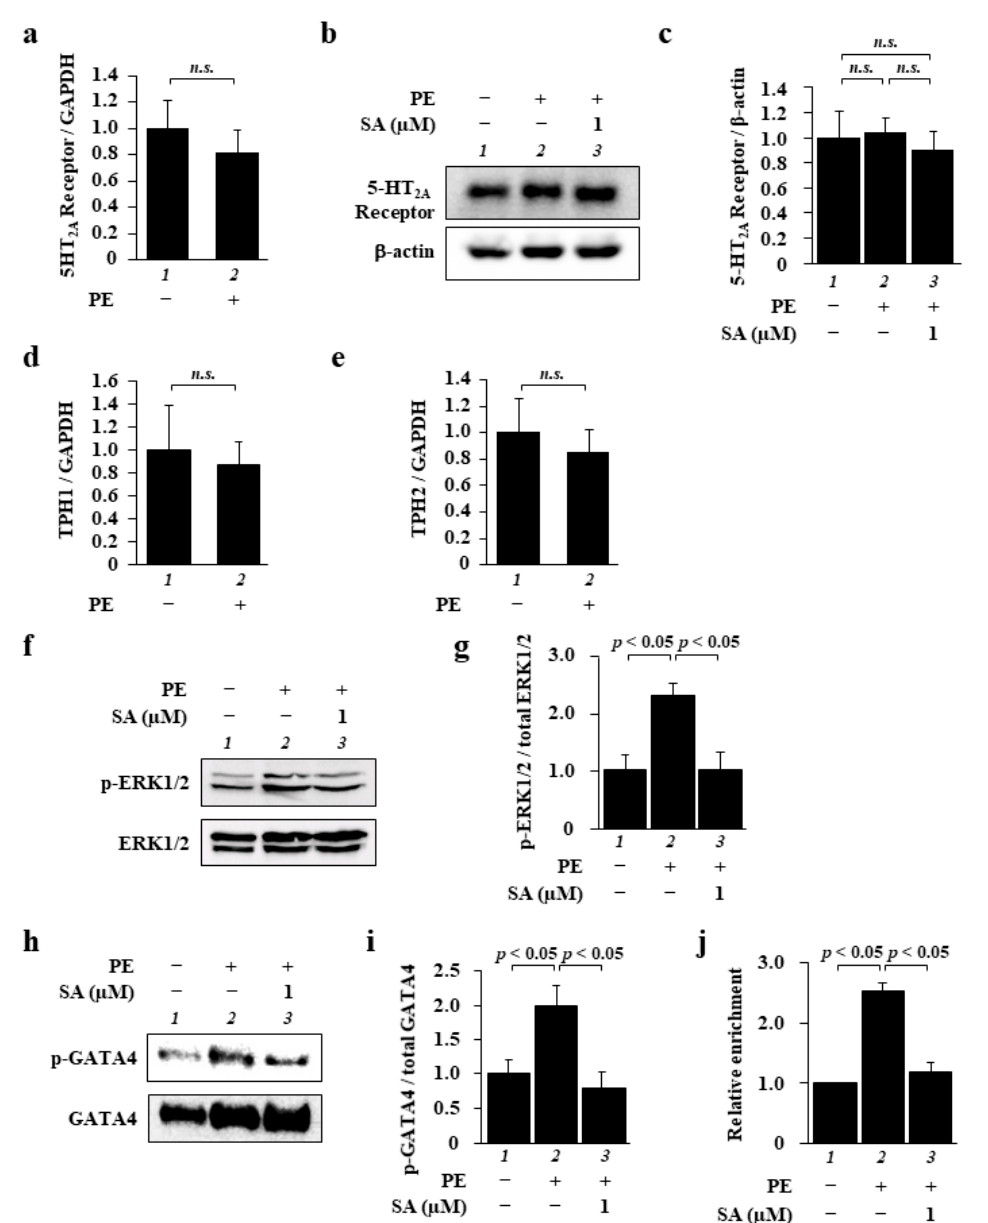
Figure 2. Sarpogrelate inhibited the ERK1/2–GATA4 signaling pathway in cardiomyocytes. ( a ) The mRNA levels of the 5-HT 2A receptor were examined at 48 h after PE stimulation. Quantitative PCR data are presented as the mean ± SEM of three individual experiments. ( b , c ) WCL was extracted from cardiomyocytes at 48 h after PE stimulation. Representative Western blotting image ( b ) and quantified 5-HT 2A receptor levels ( c ). Quantification is presented as the mean ± SEM of three individual experiments; n.s., no significance. ( d , e ) Quantitative PCR was performed for TPH1 ( d ), TPH2 ( e ), and 18S. Data are presented as the mean ± SEM of three individual experiments; n.s., no significance. ( f ) WCL was extracted from cardiomyocytes at 10 min after PE stimulation and then subjected to Western blotting using anti-phospho-p44/42 MAPK (ERK1/2) (Thr202/Tyr204) antibody and anti-p44/42 MAPK (ERK1/2) antibody. ( g ) Levels of phosphorylated ERK1/2 and total ERK1/2 were quantified. Data are presented as the mean ± SEM of three individual experiments. ( h ) The NE fraction was isolated from the cells at 1 h after PE stimulation and then subjected to Western blotting using anti-GATA4 (phospho S105) antibody and GATA4 antibody. ( i ) Levels of phosphorylated GATA4 and total GATA4 were quantified. Data are presented as the mean ± SEM of three individual experiments. ( j ) A ChIP assay was performed using anti-GATA4 anti-body, and quantitative PCR was performed for ANF and 18S. Data are presented as the mean ± SEM of three individual experiments.